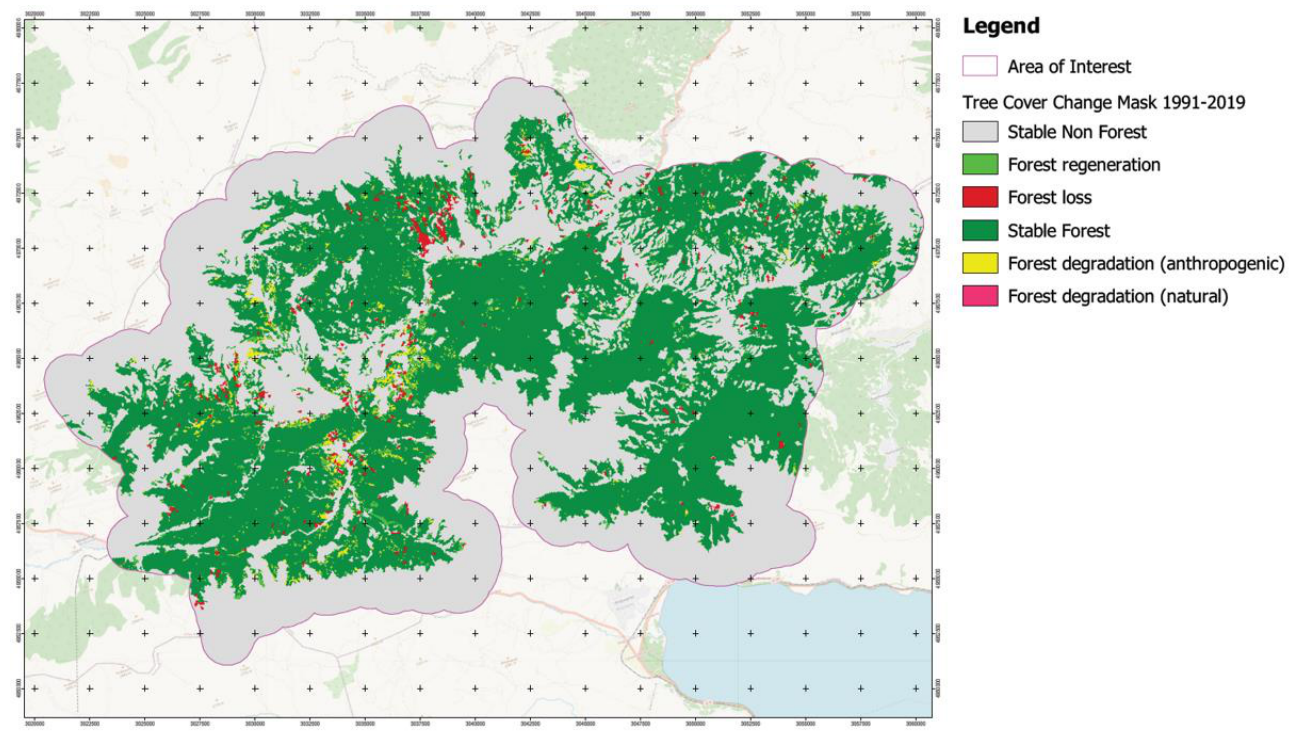
Figure 11. Evolution of Forest Perturbation in hectares, over the 1991 to 2019 period.